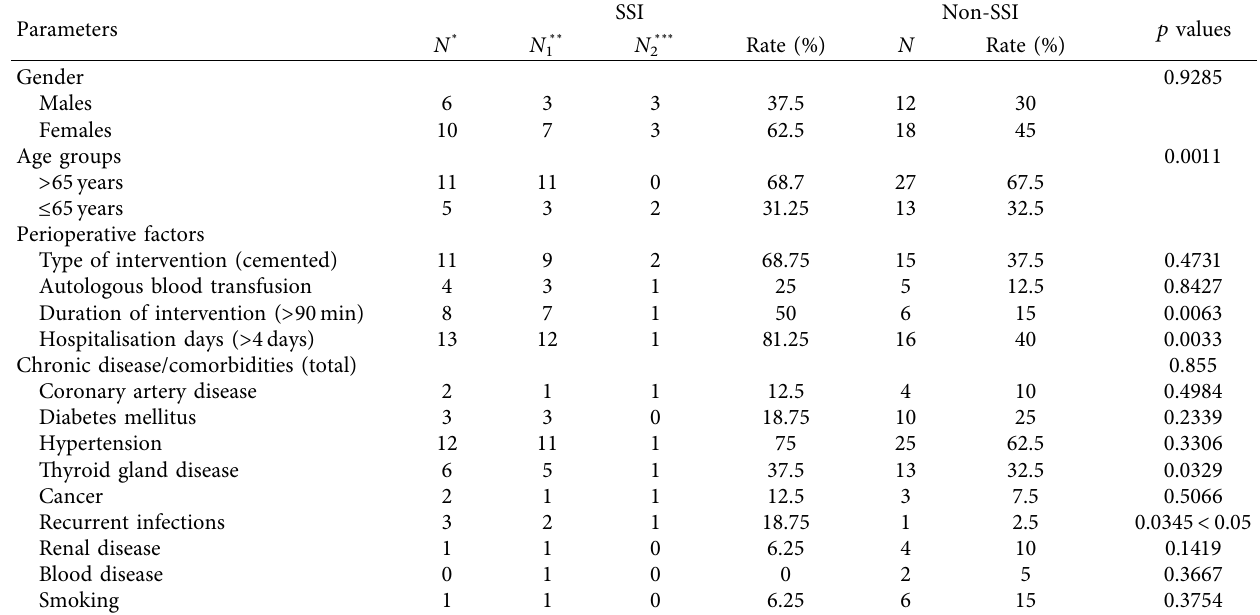
Table 5: Risk factors associated with